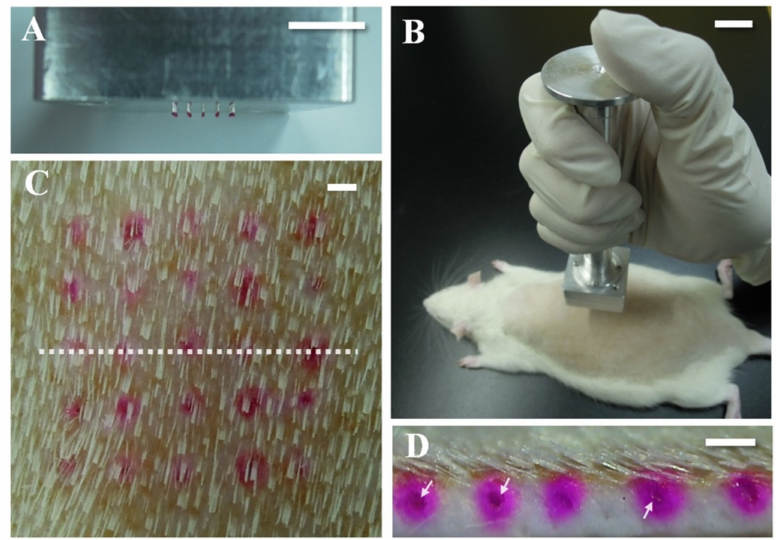
Figure 18. In vivo skin penetration study: ( A ) Troy MNs were assembled with an applicator into an array (5 × 5). ( B ) The applicator was applied to rat dorsal skin vertically by hand. ( C ) Image of skin with applied Troy MNs. The array of red spots indicates the penetrated site of rhodamine B-encapsulated Troy MNs and the white dotted line represents the vertically sliced line used to obtain sectional tissue. ( D ) Skin sectional image. Red spots mark delivered rhodamine B in the skin and the white arrow indicates undissolved parts of DMNs. Scale bars, 10 mm ( A , B ) and 1.0 mm ( C , D ) [176]. Reproduced with permission from Kim et al., The Troy MN: A Rapidly Separating, Dissolving MN Formed by Cyclic Contact and Drying on the Pillar (CCDP); published by PLoS One, 2013.